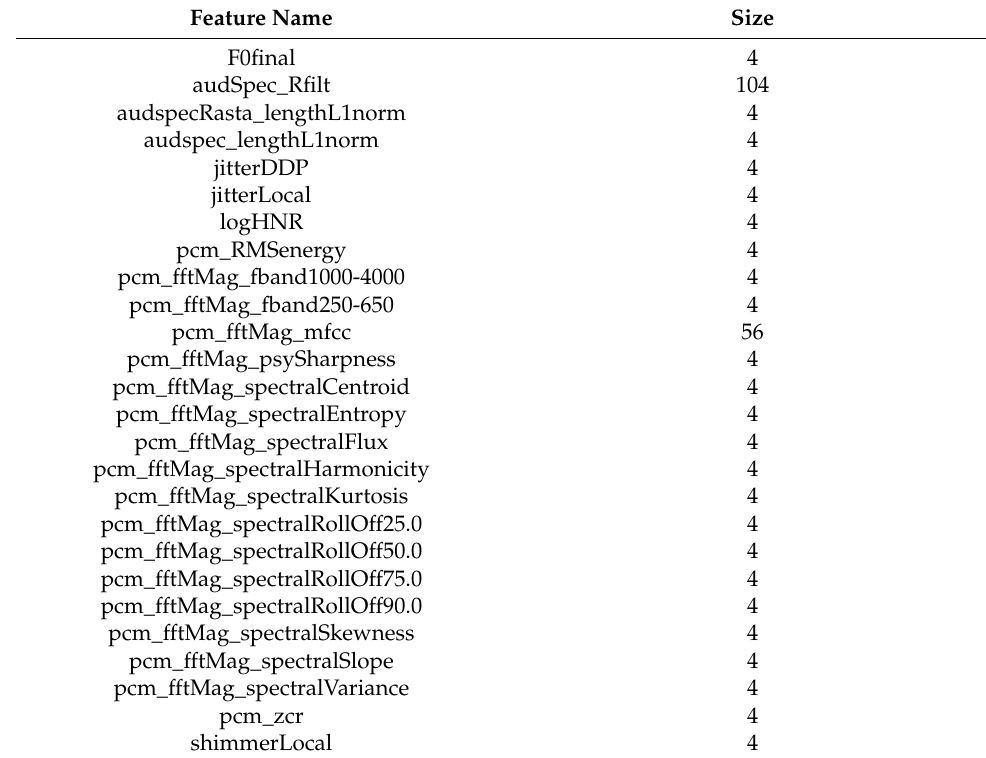
Table 4. List of 260 features extracted when using the configuration file IS13_ComParE_lld-func.conf from openSMILE. For a detailed description of these features, the reader is referred to